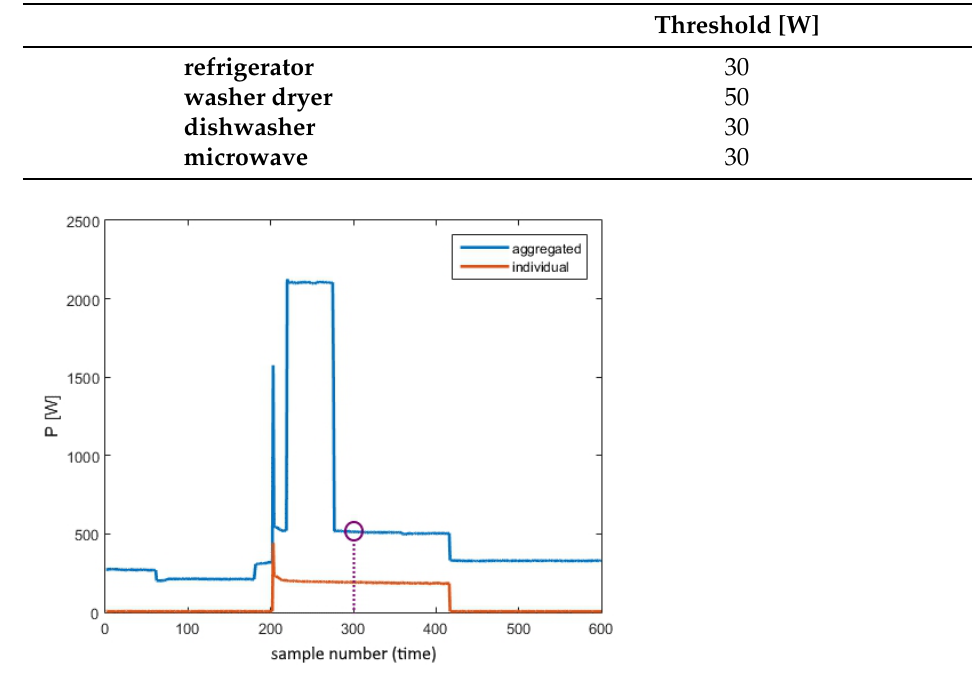
Table 3. Thresholds for estimating appliance activity labels.